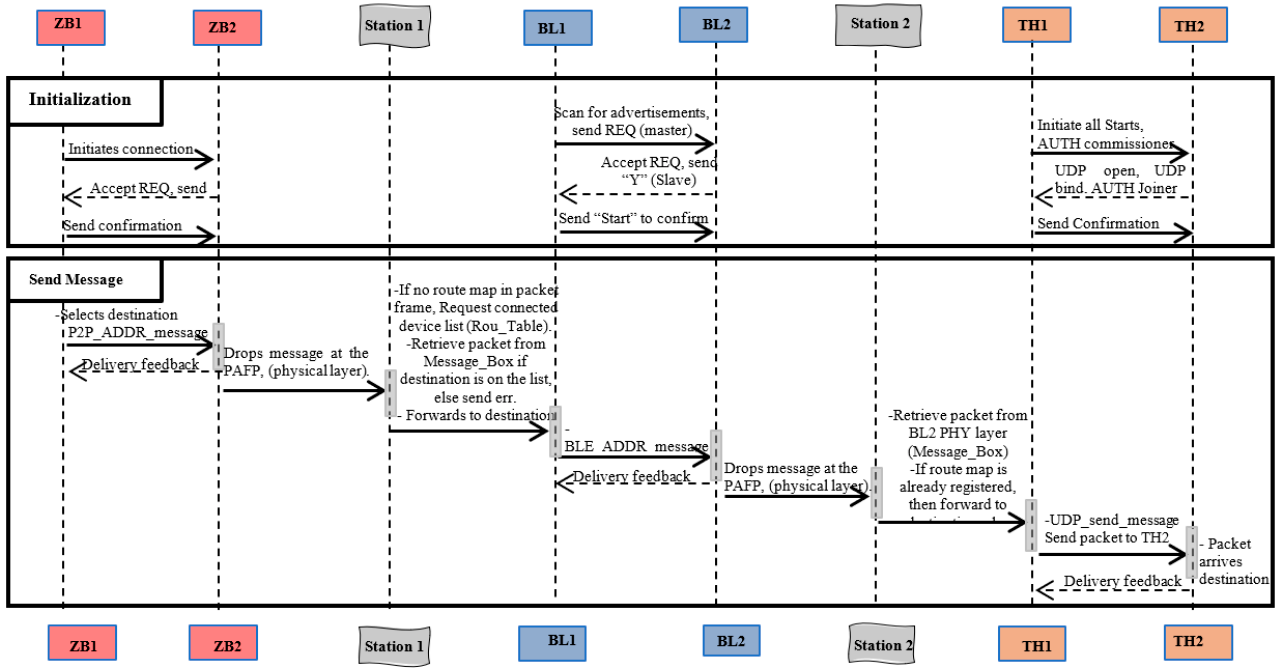
Figure 3. Sequence Diagram, Conversion, and Handing Over Process of the Connected Network Protocol on JosNet.